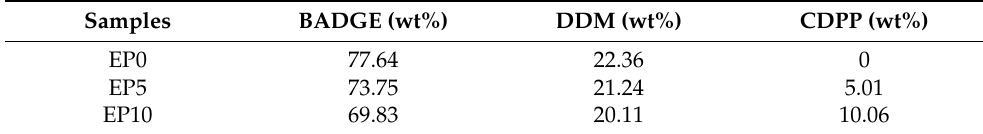
Table 1. Formulation of the epoxy adhesives with different CDPP contents.